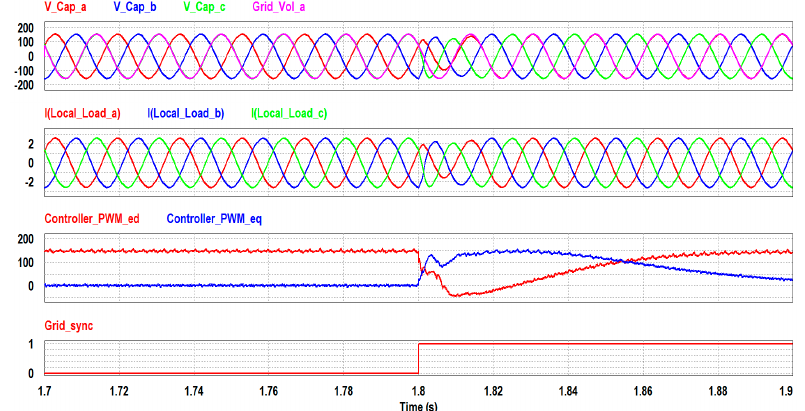
Figure 6. Simulation results with a direct grid injection to the reference voltage. (From top to bottom: Measured three phase inverter output voltages and a phase grid voltage, three phase local load currents, PWM d - q controller outputs, and GS status signal). Energies 2017 , 10 , 1514